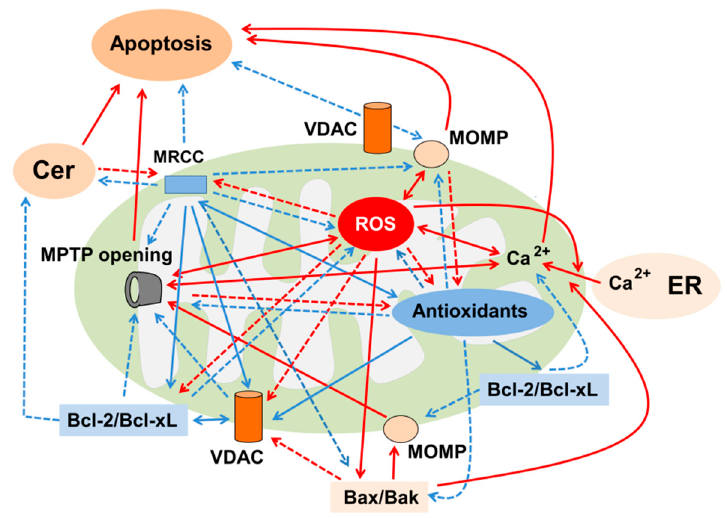
Figure 3. Interaction between ROS/antioxidants and mitochondria in the regulation of apoptosis. Oxidant stress inhibits MRCC, which induces ROS production. ROS and antioxidants inhibit each other. ROS inhibit MRCC, resulting in Cer production, MPTP opening, MOMP, decreased VDAC expression, suggestive of VDAC closure, and a decreased Bcl-2/Bax ratio, leading to apoptosis, while antioxidants and Bcl-2 prevent these events. Cer inhibits MRCC, leading to ROS production. Both ROS and Cer activate Bax/Bak, which enhances the mitochondrial uptake of Ca 2+ by enhancing the transfer of Ca 2+ from the ER, and these events trigger MPTP opening, leading to apoptosis. ROS increase intracellular Ca 2+ , which further enhances ROS production, while Bcl-2 inhibits this event and apoptosis by increasing the capacity of mitochondria to store and buffer Ca 2+ . Inhibition of MPTP opening and MOMP prevents ROS production and restores antioxidant levels. In contrast, antioxidants restore MRCC and loss of MMP, increase the expression of VDAC and Bcl-2/Bax ratio, and prevent an increase in intracellular Ca 2+ which induces loss of MMP, ameliorating apoptosis. Antioxidants prevent an ROS-induced increase in intracellular Ca 2+ by increasing Bcl-2 expression, which prevents a rise in intracellular Ca 2+ by increasing the capacity of mitochondria to buffer Ca 2+ , ameliorating apoptosis. Anti-apoptotic Bcl-2 functions as an antioxidant and inhibits ROS-induced Cer formation. Abbreviations; Cer; ceramide, MMP; mitochondrial membrane potential, MOMP; mitochondrial outer membrane permeability, MPTP; mitochondrial transition pore, MRCC; mitochondrial respiratory chain complex, ROS; reactive oxygen species, VDAC; voltage-dependent anion channel. Red arrow; apoptotic pathway, blue arrow; anti-apoptotic pathway, → ; stimulation, dashed arrow; inhibition.